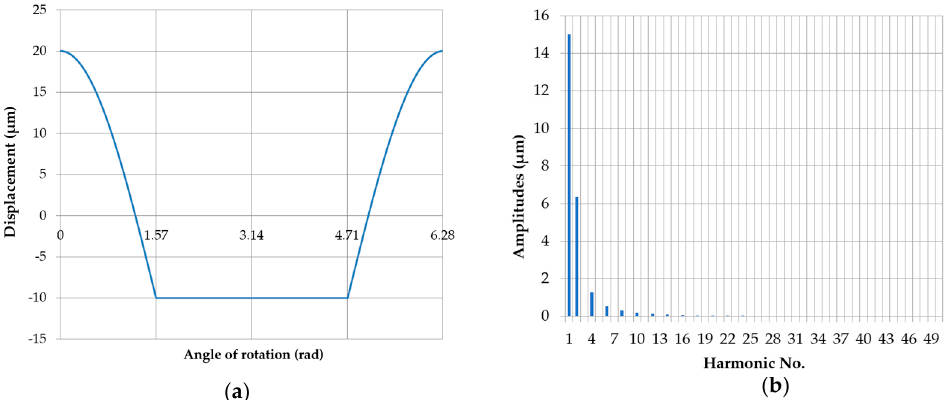
Figure 19. Eccentric movement profile of the center of the roundness profile being measured when the supports were set at the same height ( x = 0 mm), with an eccentricity of the main journal e = 0.03 mm ( a ); discrete amplitude spectrum ( b ). Table 6. Amplitudes of the harmonic components for the eccentric movement of the center of the roundness profile being measured when the supports were set at the same height ( x = 0 mm), with an eccentricity of the main journal e = 0.03 𝑚𝑚 .